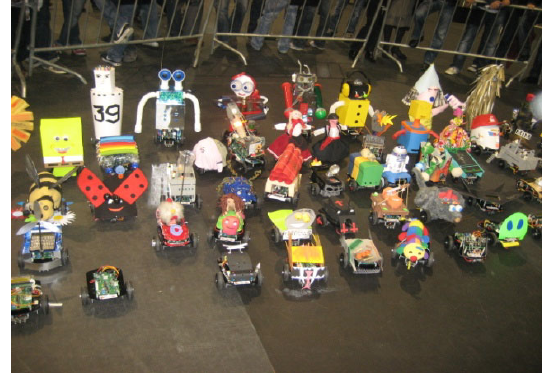
Figure 3. Roboparty event – some robots